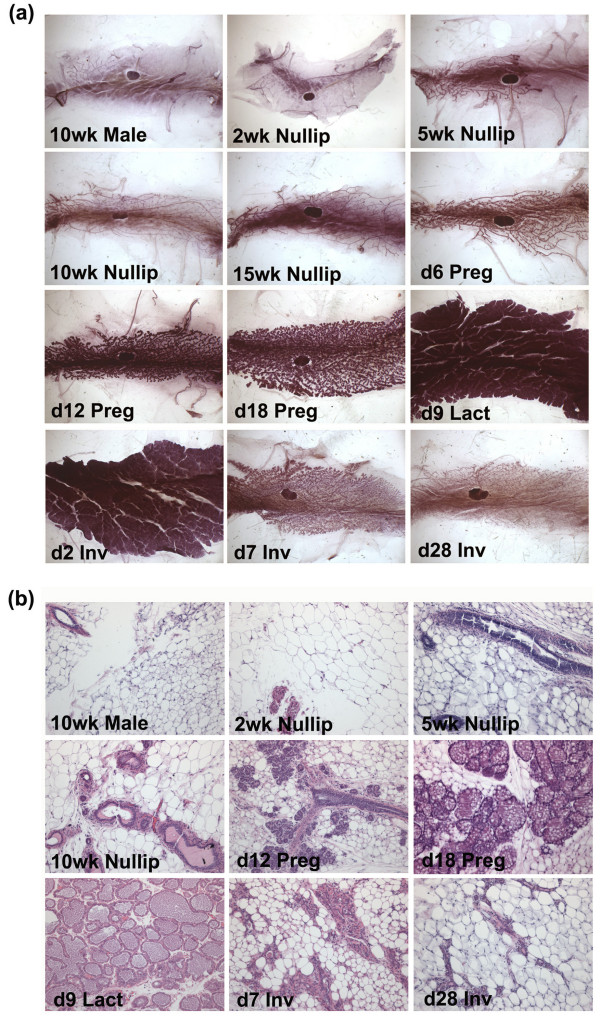
Mammary gland morphology during the development. (a) Analysis of carmine-stained whole mounts (magnification 6×) and (b) hemotoxylin and eosin (H&E)-stained sections (magnification 100×) showing the relative changes in size of the epithelial and adipose compartments of the number 4 mammary gland at the indicated time points during mammary gland development.